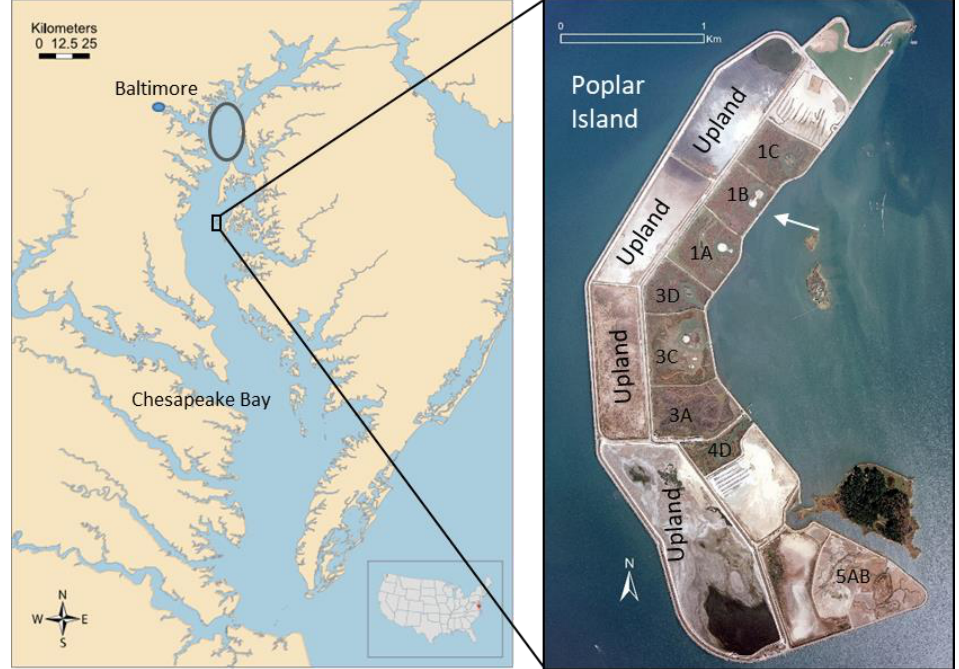
Figure 1. Location of Poplar Island in Chesapeake Bay and a detailed map of the research site. White arrow points to the Cell 1B marsh, the focus of this study; oval indicates the source of dredged material used at Poplar Island. (Chesapeake Bay map by Tracey Saxby, Kate Boicourt, Integration and Application Network, ian.umces.edu/media-library).